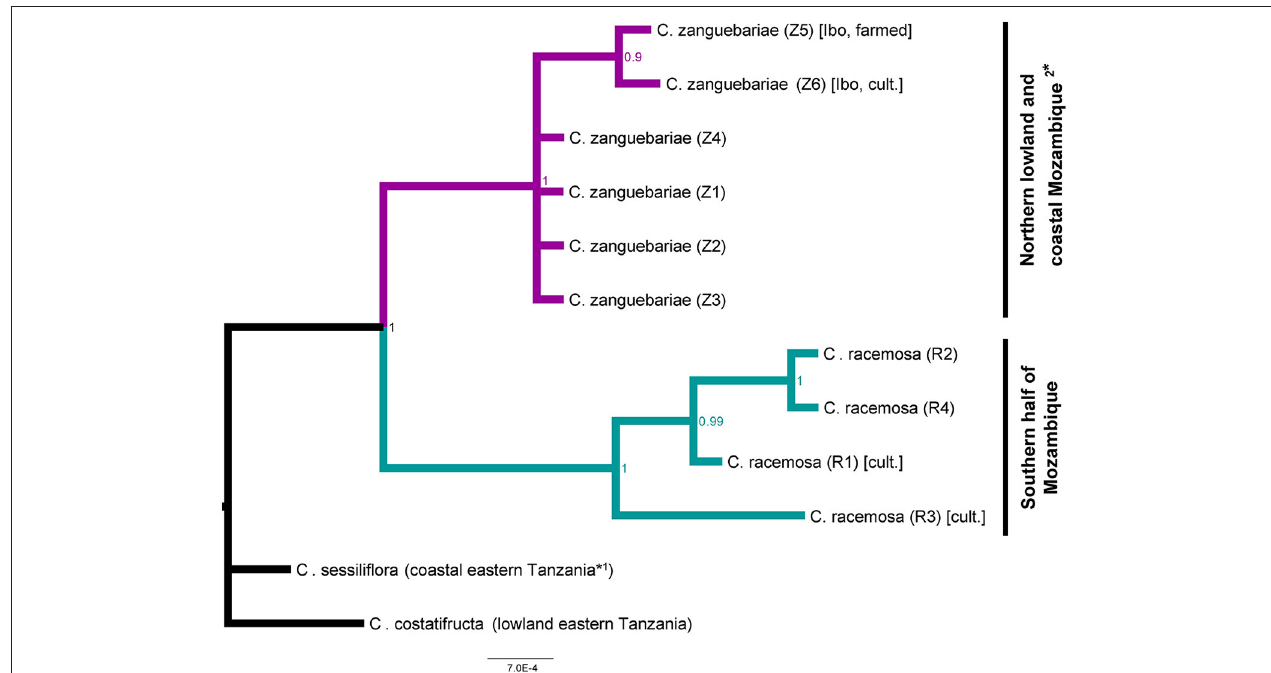
FIGURE 7 | Combined ITS and plastid maximum clade credibility tree. Bayesian posterior probabilities are indicated at nodes. See Table 1 for accession information. Notes: 1* Coffea sessiliflora also occurs in coastal eastern Kenya; 2* C. zanguebariae also occurs in southern Tanzania, and northern Zimbabwe.